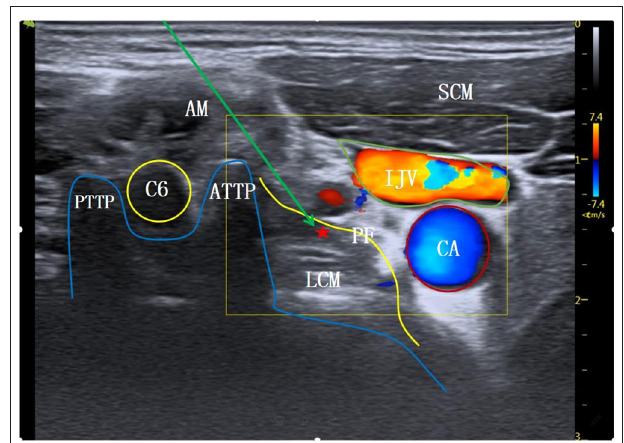
FIGURE 1 | The level at C6 transverse process. AM, anterior scalene muscle; SCM, sternocleidomastoid muscle; C6, the 6th cervical nerve root; ATTP, anterior tubercle of transverse process; PTTP, posterior tubercle of transverse process; PF, anterior vertebral fascia; LCM, long neck muscle; ⋆ Indicates stellate ganglion block area; ց Indicates simulated puncture path; IJV, internal jugular vein; CA, carotid